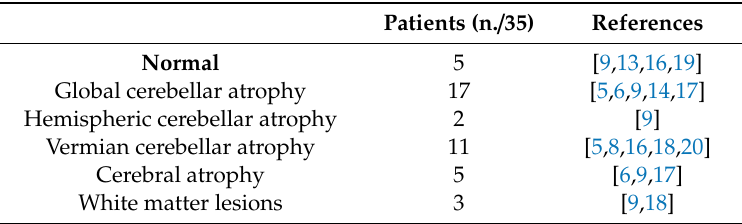
Table 2. MRI findings of 35 KCND3 mutation